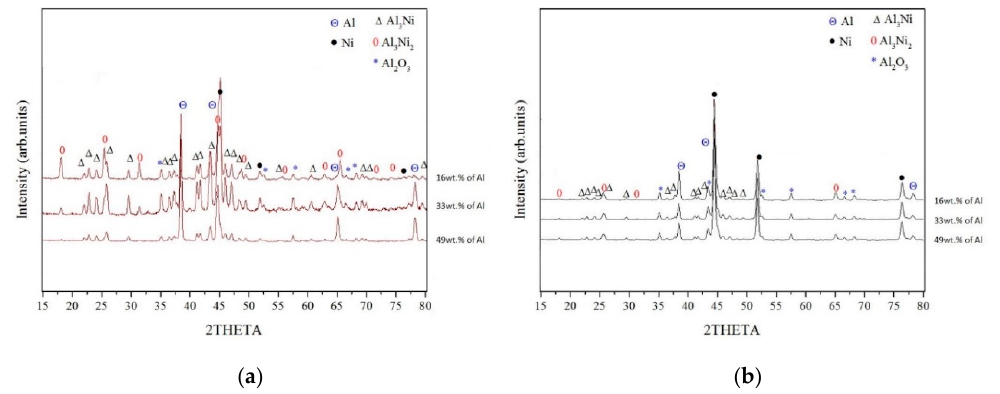
Figure 13. XRD diffraction patterns of coatings heat-treated in furnace-620 °C ( a ) by resistance spot Figure 13. XRD di ff raction patterns of coatings heat-treated in furnace-620 ◦ C ( a ) by resistance spot welding process-parameters No. 4 and ( b ). welding process-parameters No. 4 and ( b ).